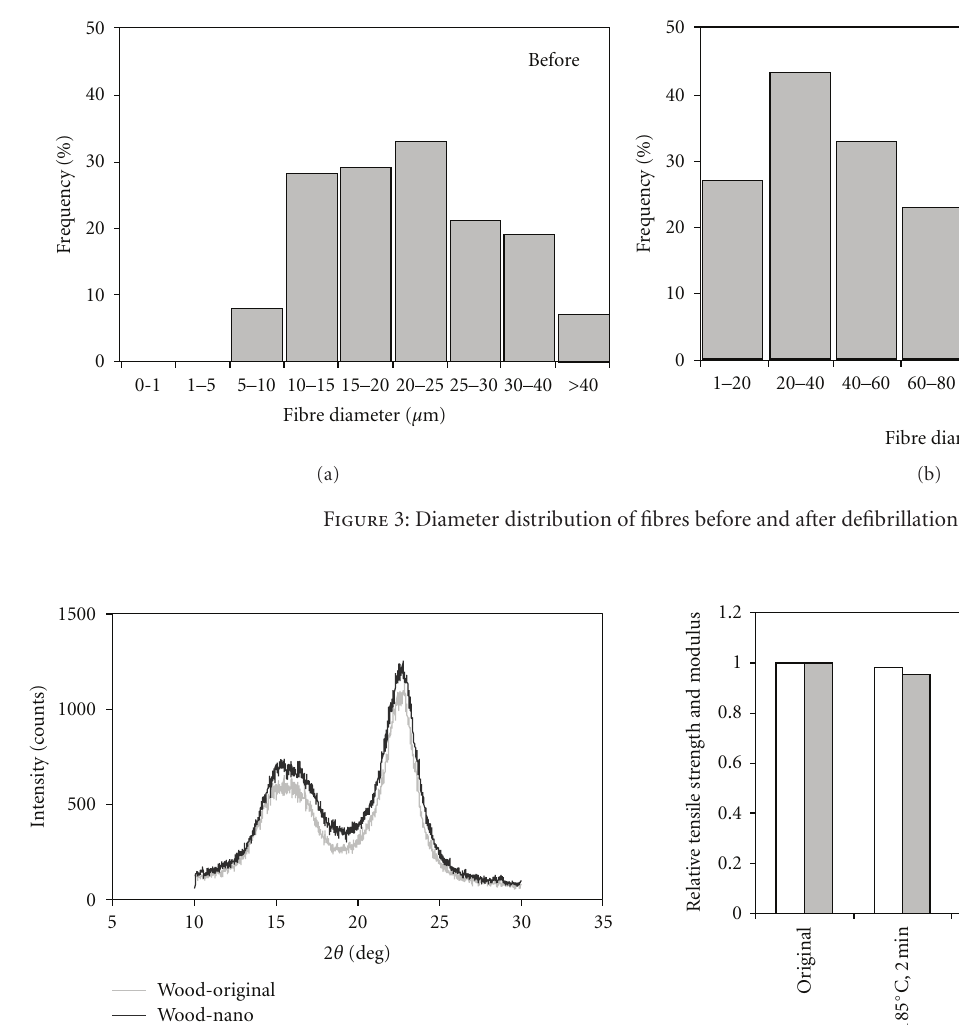
Figure 4: XRD of wood fibres before and after defibrillation.